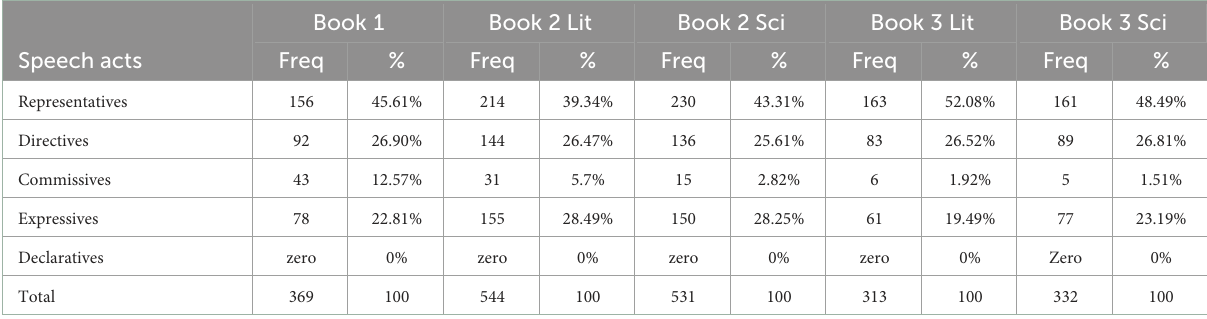
TABLE 1 Frequency and percentage of speech acts in 21st Century English for Libya secondary 1, 2, and 3 course books and